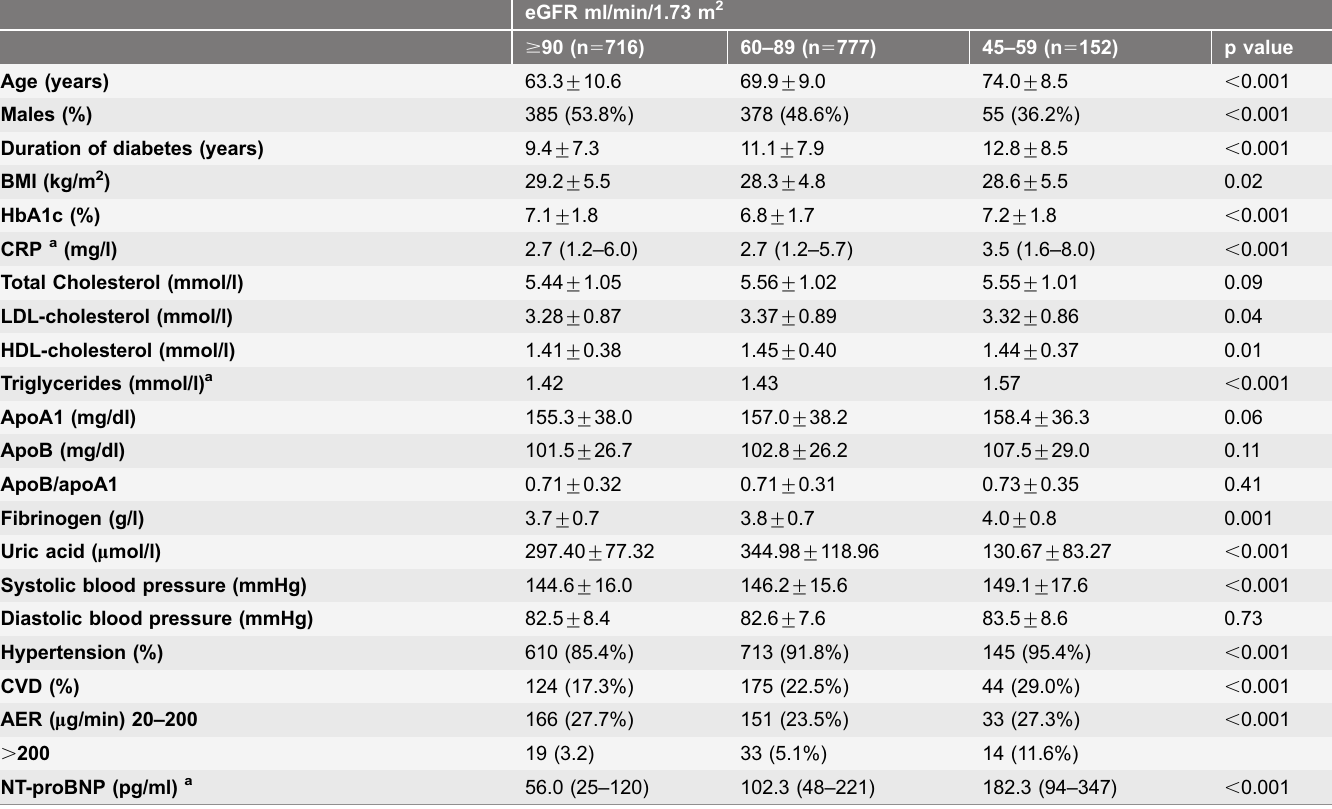
Table 1. Characteristics of people with type 2 diabetes in the Casale Monferrato Study with NT-proBNP assessment at the baseline examination (2000), by estimated glomerular filtration rate